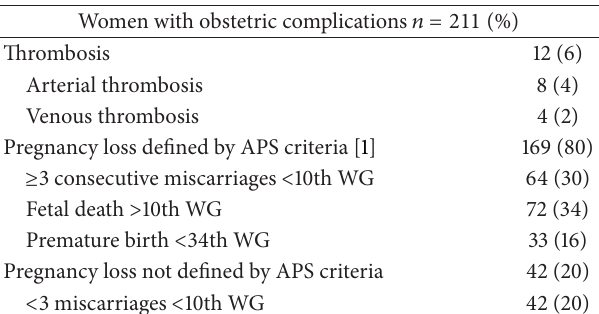
Table 2: Patients’ clinical